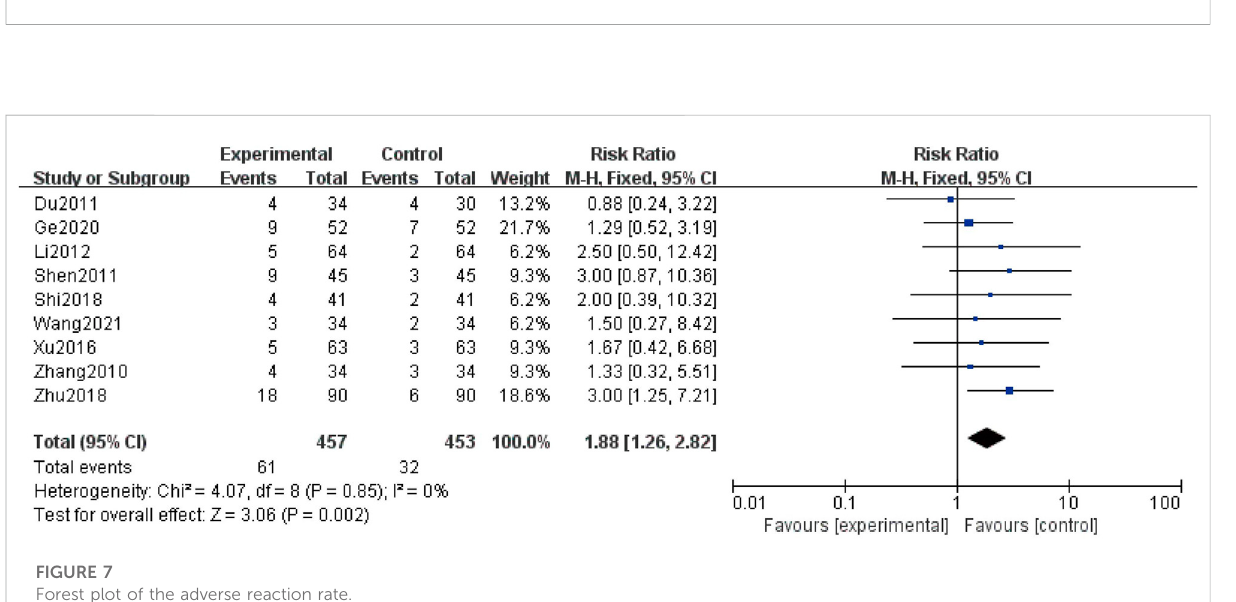
FIGURE 7 Forest plot of the adverse reaction